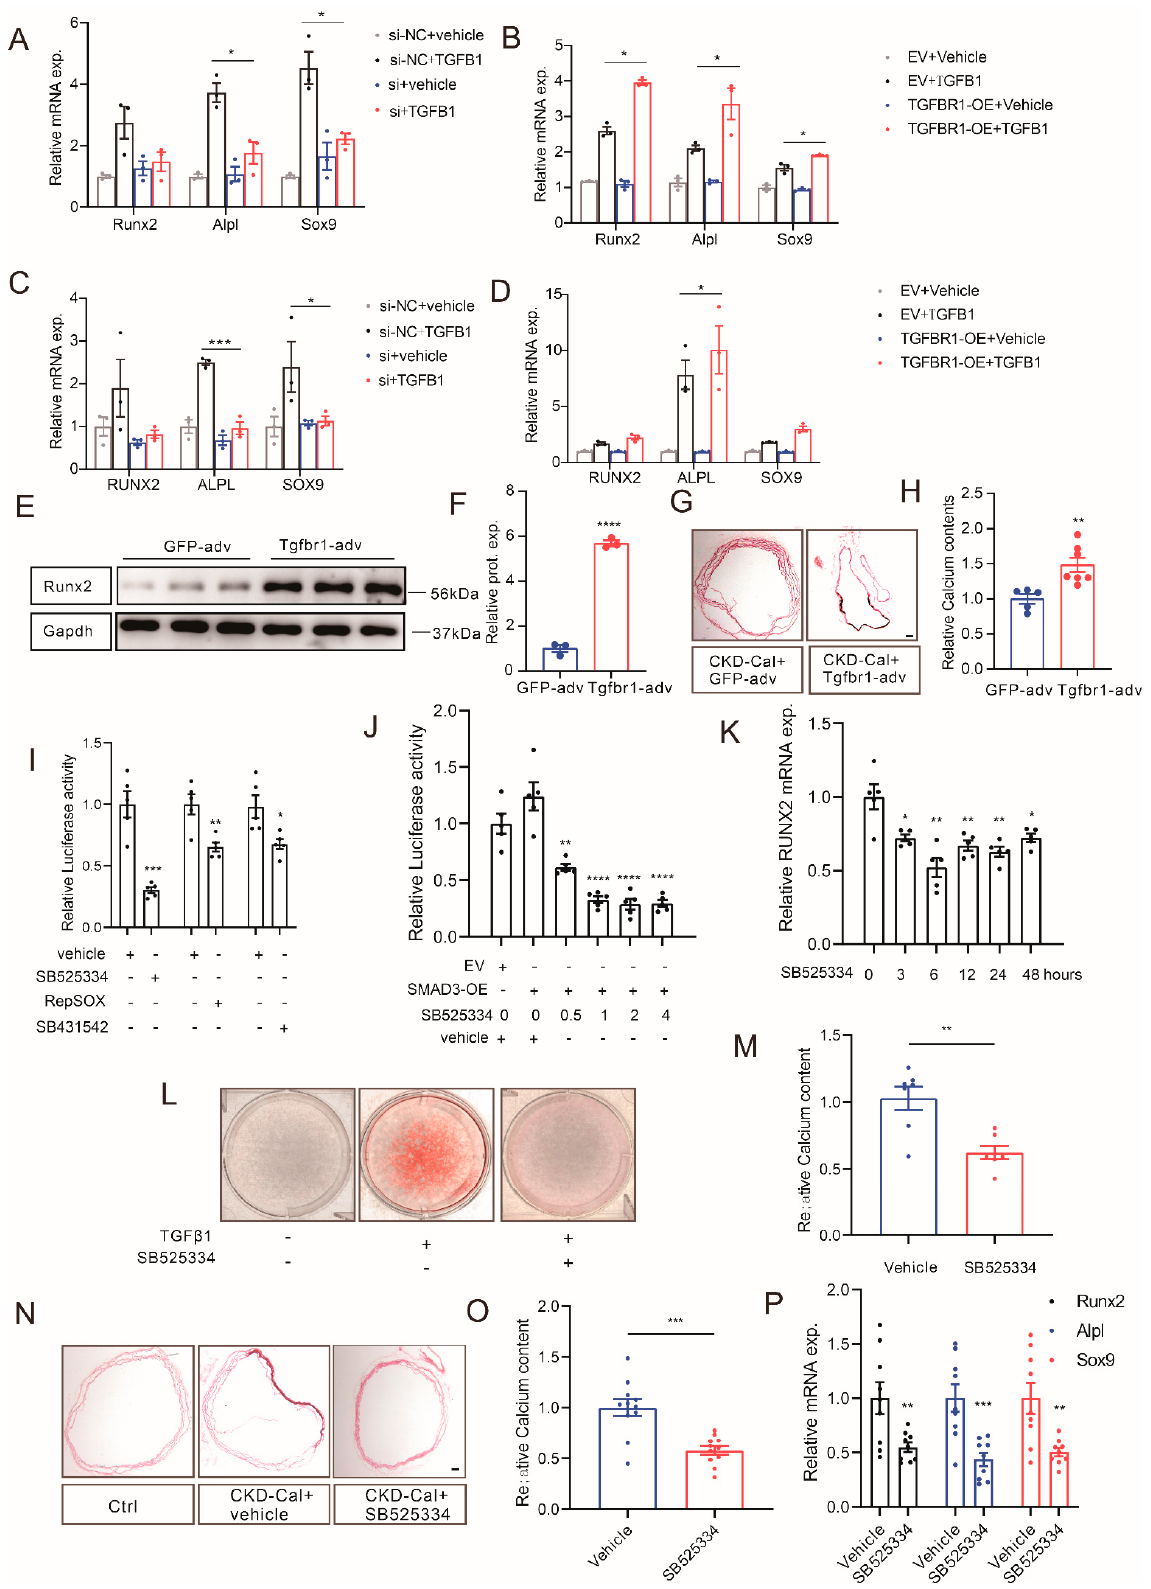
Figure 6. Manipulating TGFBR1 levels regulates vascular calcification in CKD. Transcription levels of RUNX2, ALPL, and SOX9 in MOVAS ( A ) and HASMCs ( C ) stimulated with 10 ng/mL TGF β 1 for 24 h after being transfected with TGFBR1 siRNA for 6 h (one-way ANOVA, n >